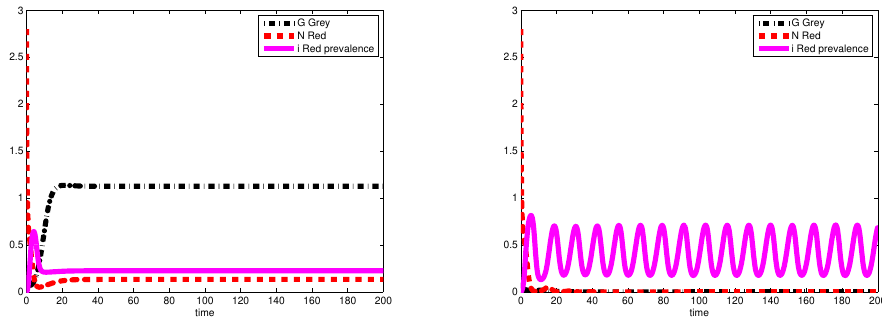
Figure 10. ( Left frame ) The coexistence equilibrium obtained with the basic parameters (3) coupled with (14). When both values of the parameters in their ranges are low, native squirrels can thrive, and prevalence is low; while the grey ones are reduced, and disease prevalence also drops. This ecosystem behavior depends more on the values of E than on those of β . ( Right frame ) Persistent oscillations in the prevalence, obtained for r = 0.1, β = 0.3, and the other parameters as given in (3) and